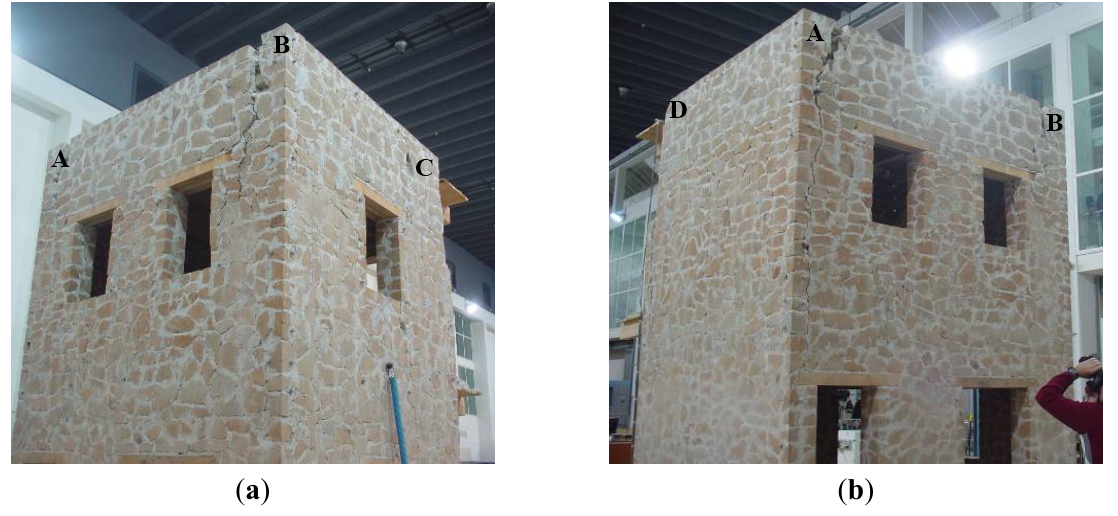
Figure 6. Diagonal cracks in the façade AB (( a ) PGA = 0.20 g) and vertical crack in the façade AB (( b ) PGA = 0.25 g).